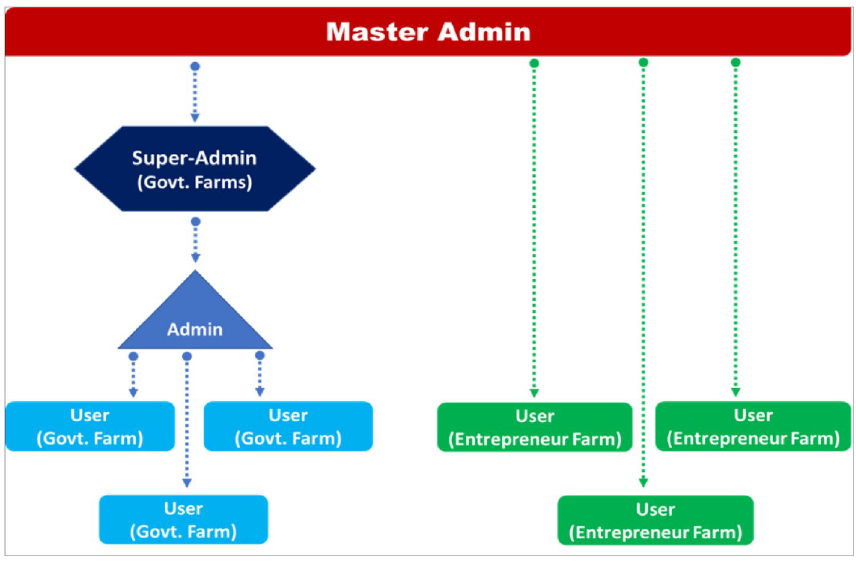
Figure 4. Framework used for the creation of user